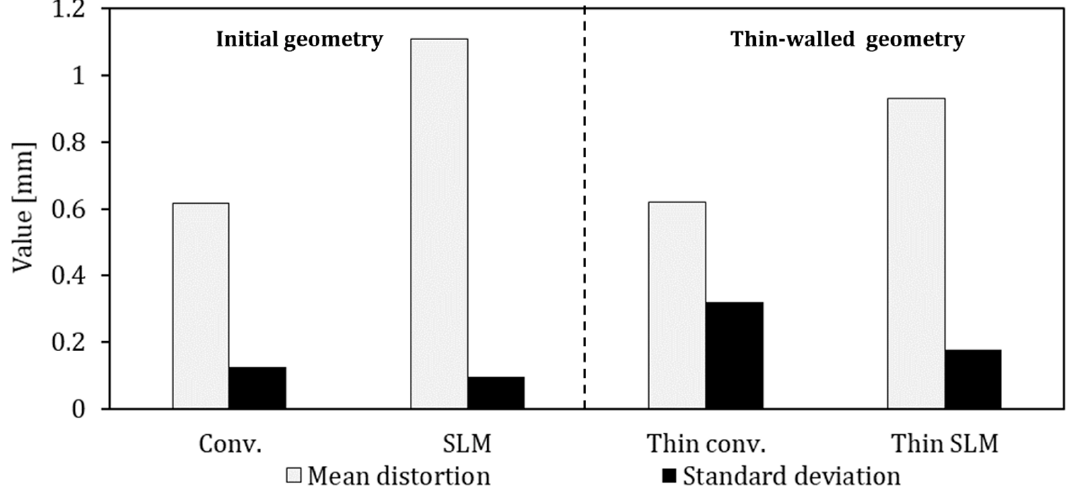
Figure 12. In-situ measured temperatures of casting experiments in the initial geometry and temperature control set to 30 °C.